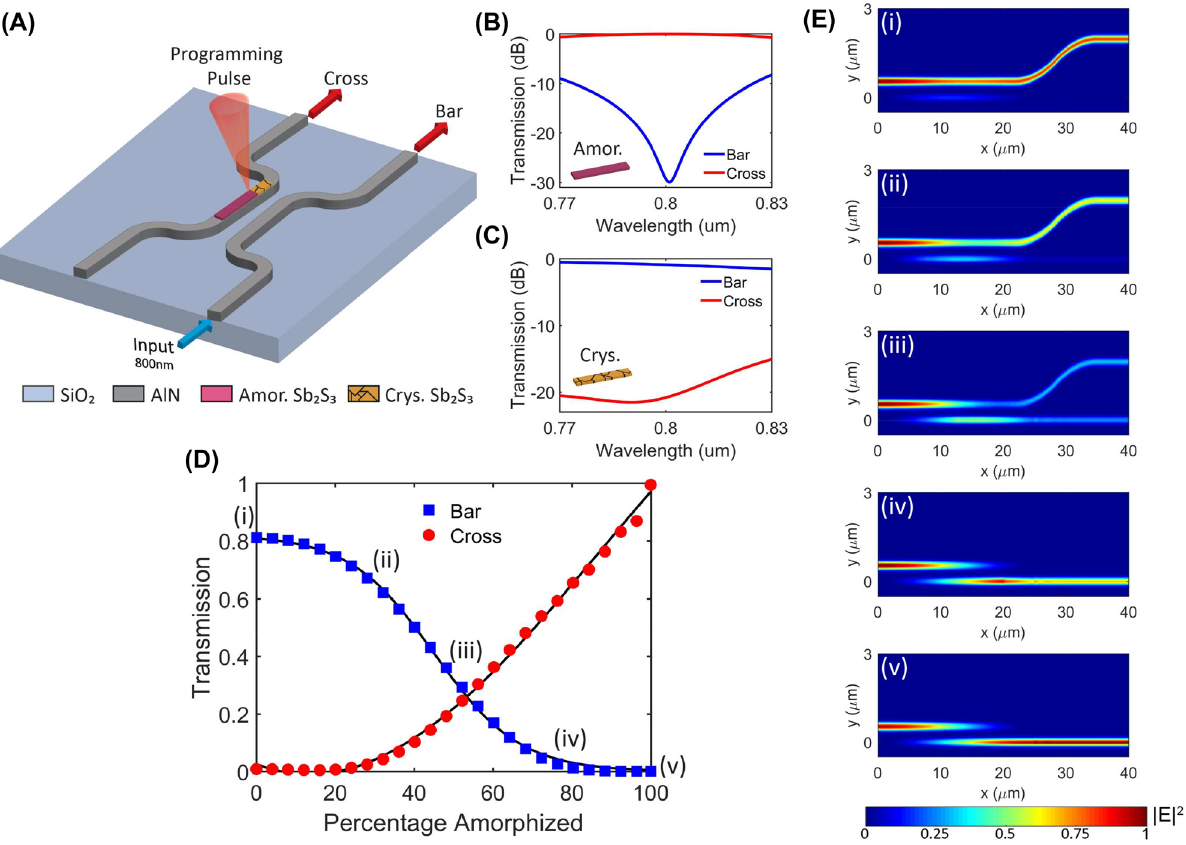
Figure6: 1X2Sb 2 S 3 -tuneddirectionalcouplerfortheMZIweights.(A)Schematicdiagramofthedirectionalcouplerdevice.Performanceofthe directional coupler across 770 – 830 nm wavelength in the (B) amorphous and (C) crystalline state. (D) Transmission values at the different ports for different amorphized Sb 2 S 3 length at the 800 nm wavelength. (E) Corresponding power fi eld pro fi le of the device for the fi ve states labeled in